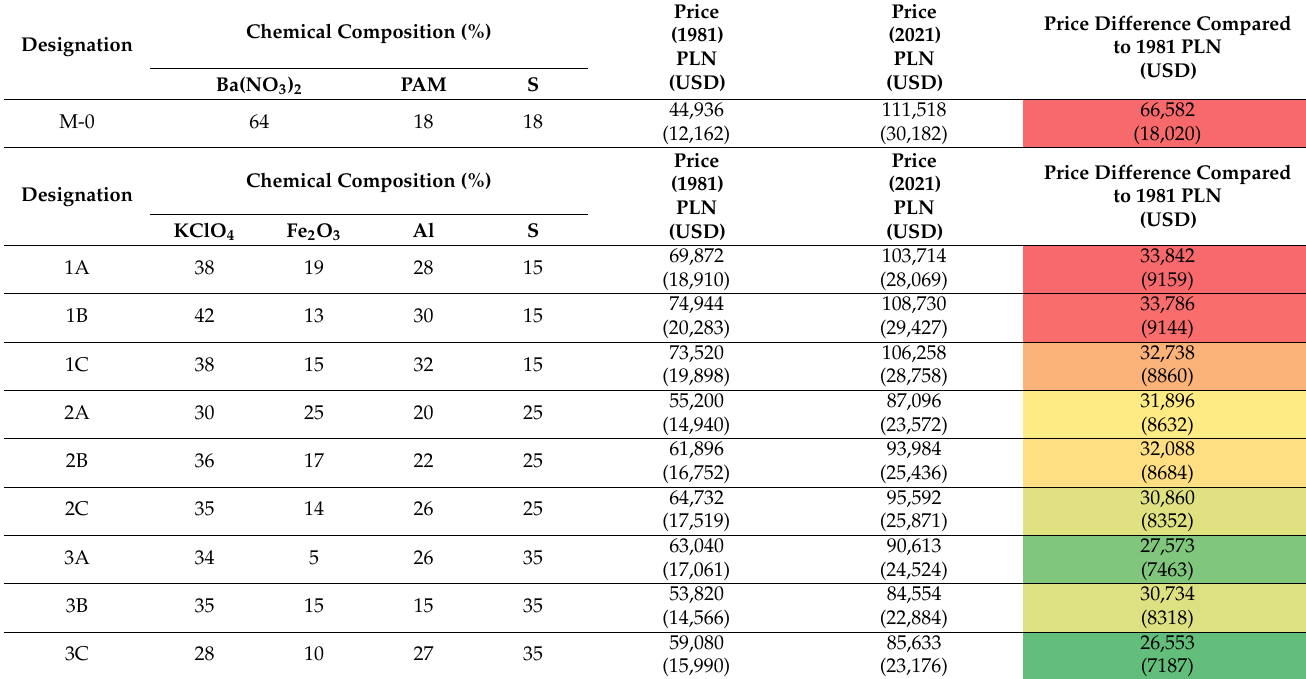
Table 11. Comparison of manufacturing costs of pyrotechnic compositions from the M-1 group for model 1, batch of 2000 kg (4409 lb) of pyrotechnic compositions.